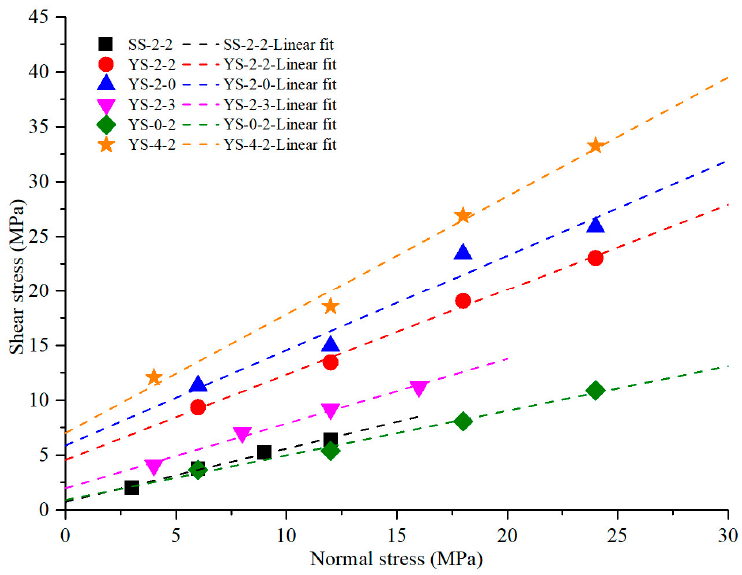
Figure 9. Scatters of shear and normal stresses and corresponding linear fit curves. Table 5. Data collection of shear stresses and calculated parameters of shear strength.